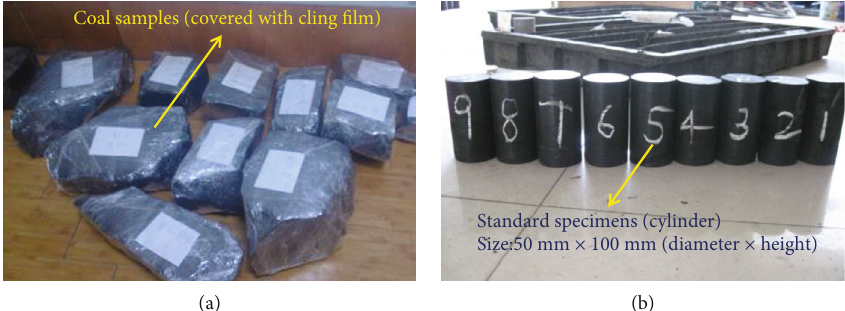
Figure 4: The picture of coal samples before and after processing. (a) Before processing. (b) After